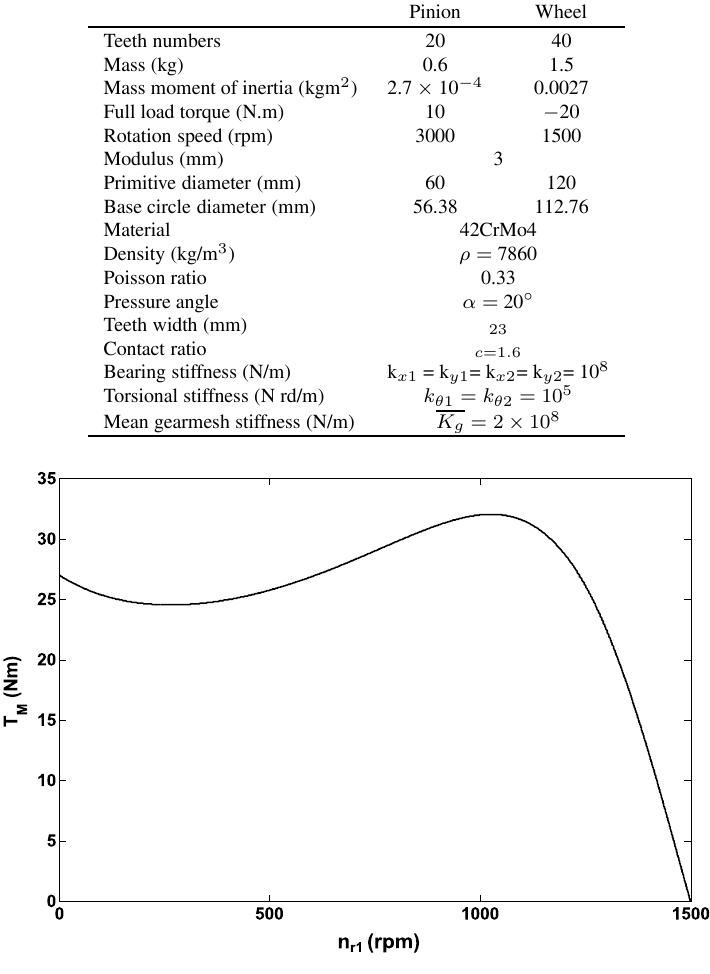
Fig. 5. Speed-Torque characteristic of the